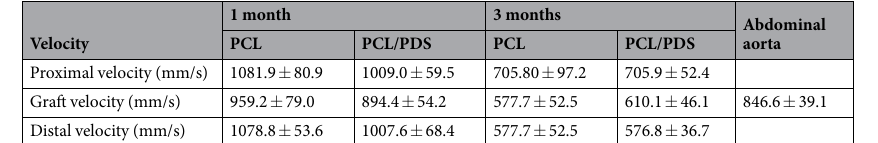
Table 1. Blood velocity the grafts measured by color Doppler